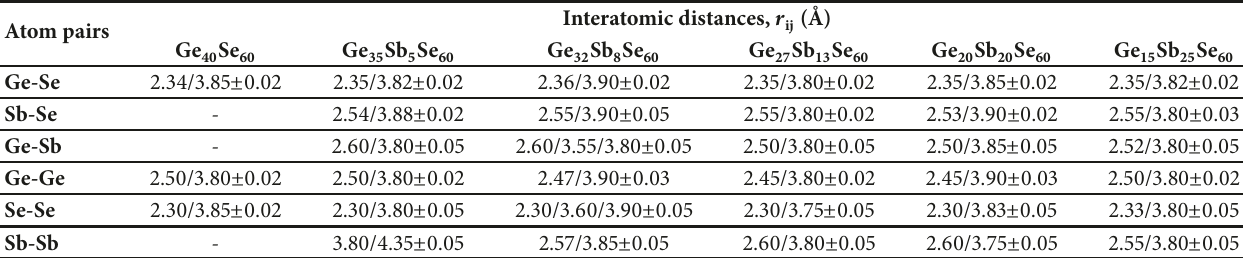
Table 3: Interatomic distances, 𝑟 ij (˚A), in chalcogenide samples obtained from the RMC simulation. Atom pairs